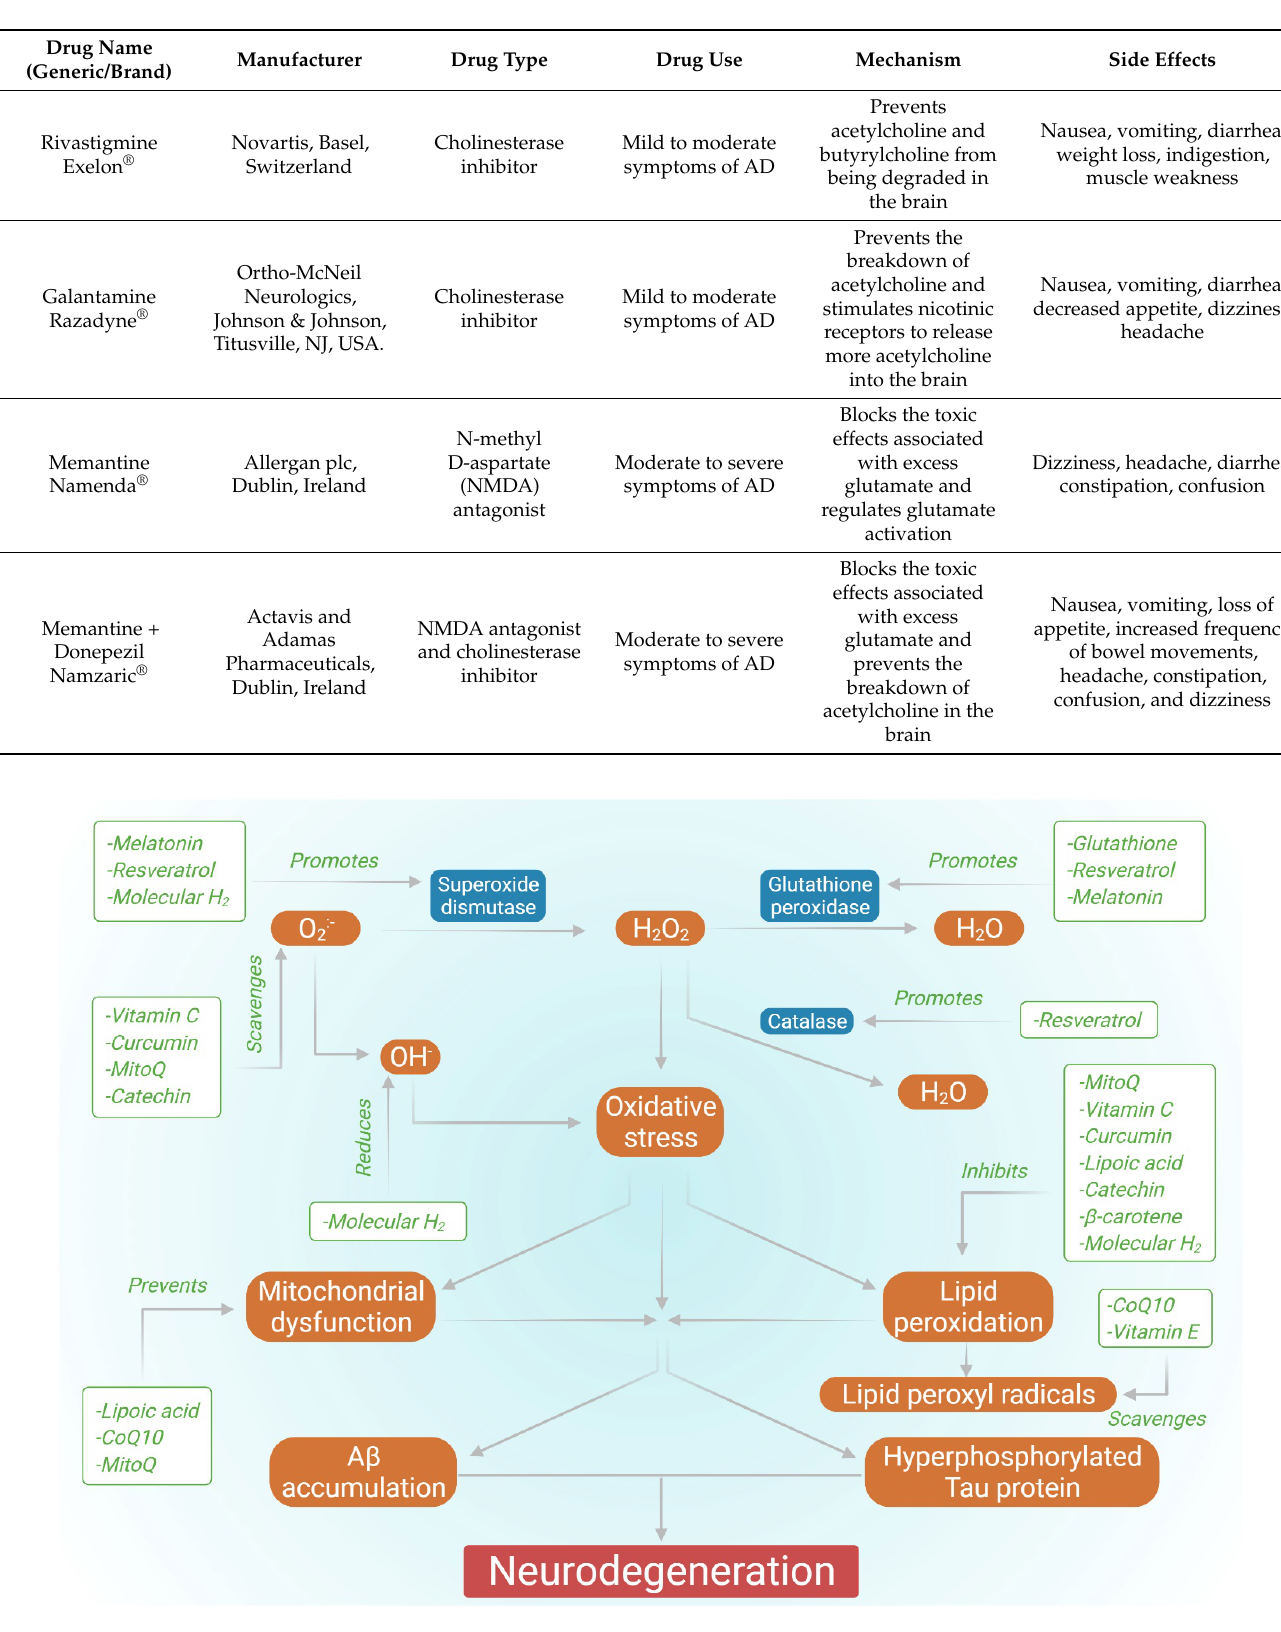
Oxidative stress is defined as an imbalance between oxidants and antioxidants that causes a rise in oxidant levels [11–14]. It is well recognized as one of the clinical markers of AD; nevertheless, it is still unclear whether oxidative stress is a cause or a consequence of the process that occurs in AD patients’ brains. Reactive oxygen species (ROS) and Aβ are the major mediators of oxidative stress. The increase in the level of non-enzymatic glycation of cellular proteins, lipoproteins, and nucleic acids results from increased glu- cose levels [15]. These products are known as advanced glycation end products (AGEs) [16]. The administration of a diet rich in AGEs in the mouse hippocampus results in ox- idative damage to the vasculature, increments in the level o f Aβ, and memory impair- ments [17]. The receptor for AGEs is RAGE (receptor for advanced glycation end-products), a pattern recognition receptor that may bind massive ligands produced from the damaged cellular environment [18] and Aβ [19]. The NADPH oxidase (NOX) is activated by RAGE’s strong interactions with its ligands, resulting in increased ROS production [20]. AGER (gene encoding polymorphism in RAGE) has been linked to a hereditary predisposition to AD [17]. There are several pieces of evidence like APP23 mice carrying APP KM670/671NL mutation, which proves the early involvement of oxidative stress even before the depo- sition of Aβ in AD, [21], where triple transgenic mice carrying PS1 M146 V, Tau P301L, and APP KM670/671NL mutations were studied [22]. In the oxidative condition, Aβ generation may also be affected by the PS1/γ -secretase complex. It has been reported that 4-hydroxynonenal (4-HNE) or 4, 4-dithiodipyridine (DTDP) induces the pathogenic shift